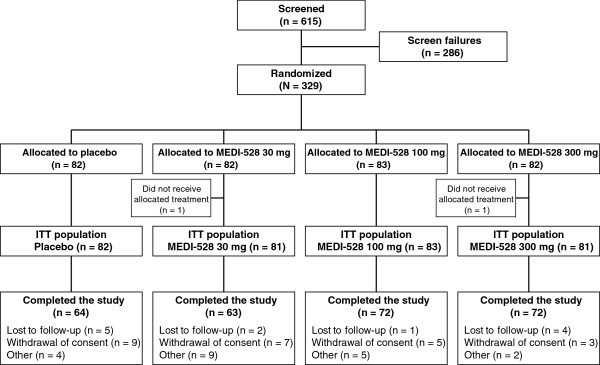
Subject disposition.